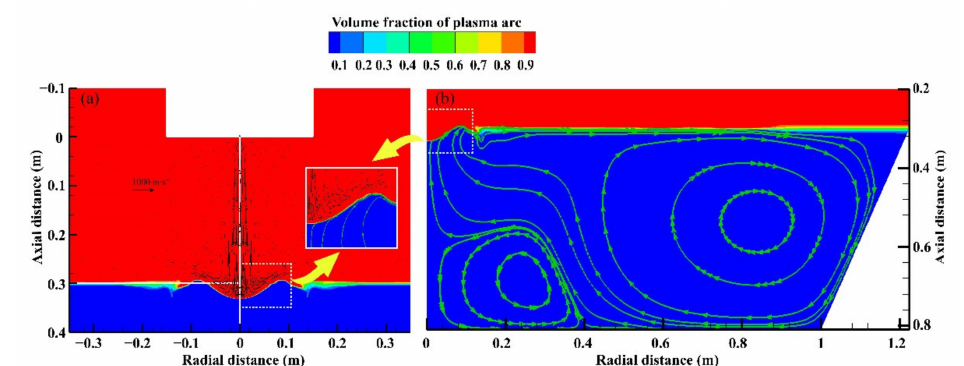
Figure 8. Flow fields in plasma arc and molten bath (case 1: t = 100 s): ( a ) plasma arc domain; ( b ) molten bath domain.